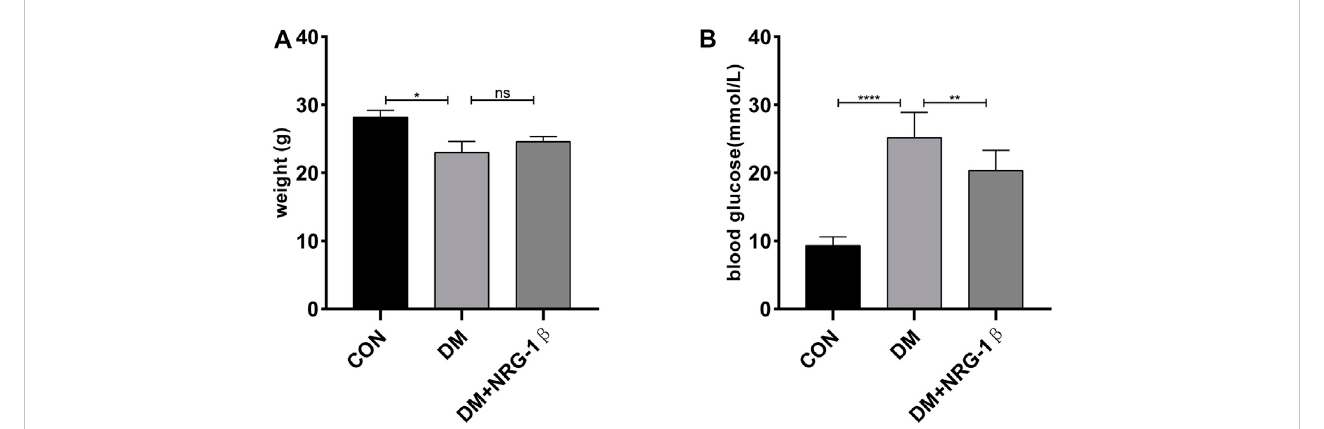
FIGURE 5 NRG-1 β improveddiabetes-inducedweightlossandattenuateddiabetes-inducedhyperglycemiainT2DMmice.EffectsofNRG-1 β onthebodyweights (A) and blood glucose levels (B) . The data are presented as the mean ± SEM. ns, p > .05; * p < .05; ** p < .01; **** p <